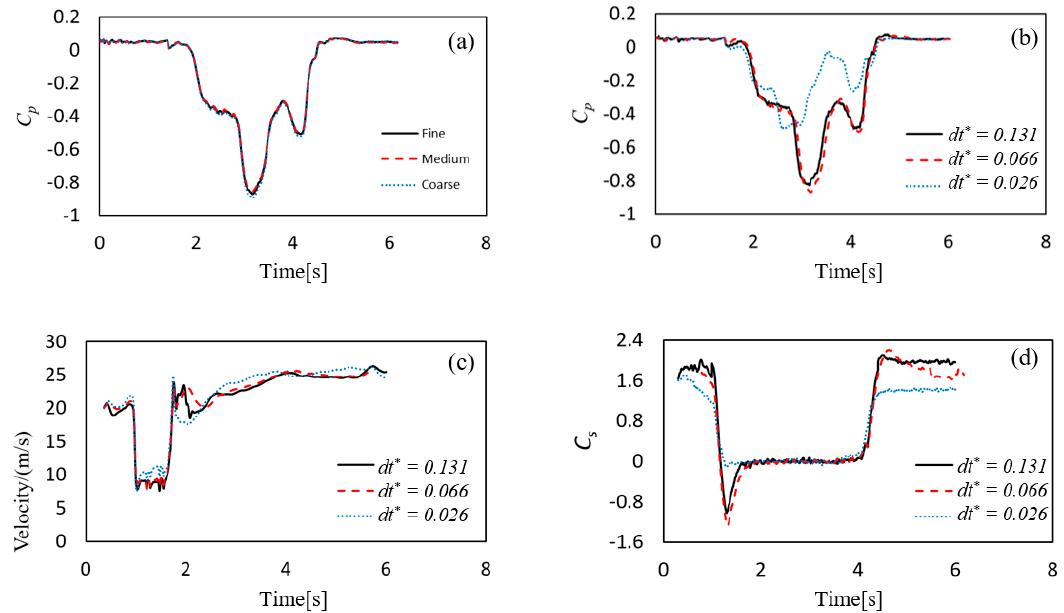
Figure 8. Grid independence and time step verification: ( a ) Grid independence visualized by C p ; time step independence visualized by ( b ) C p ; ( c ) velocity magnitude; ( d ) C s